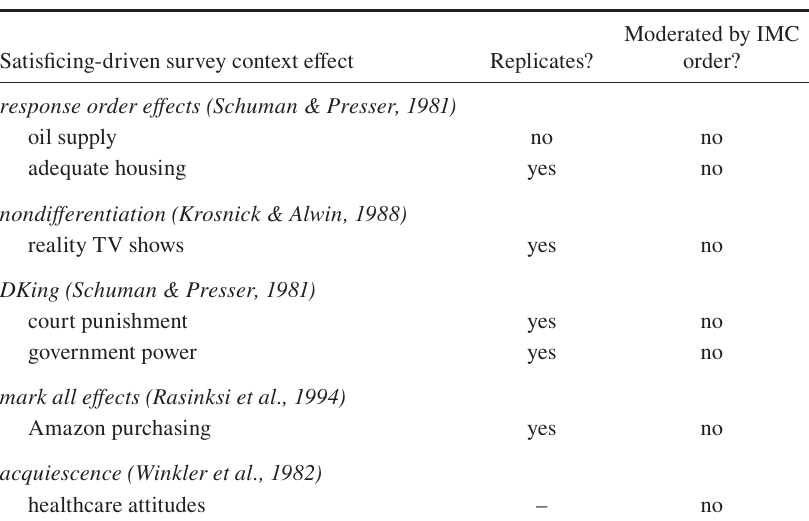
Summary of satisficing effect results Satisficing-driven survey context